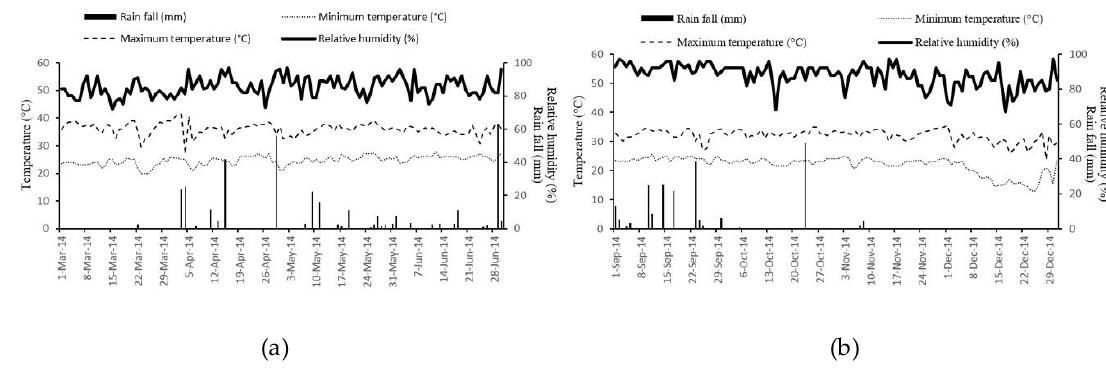
Figure 1. Rainfall (mm), relative humidity (%), maximum temperature (°C), and